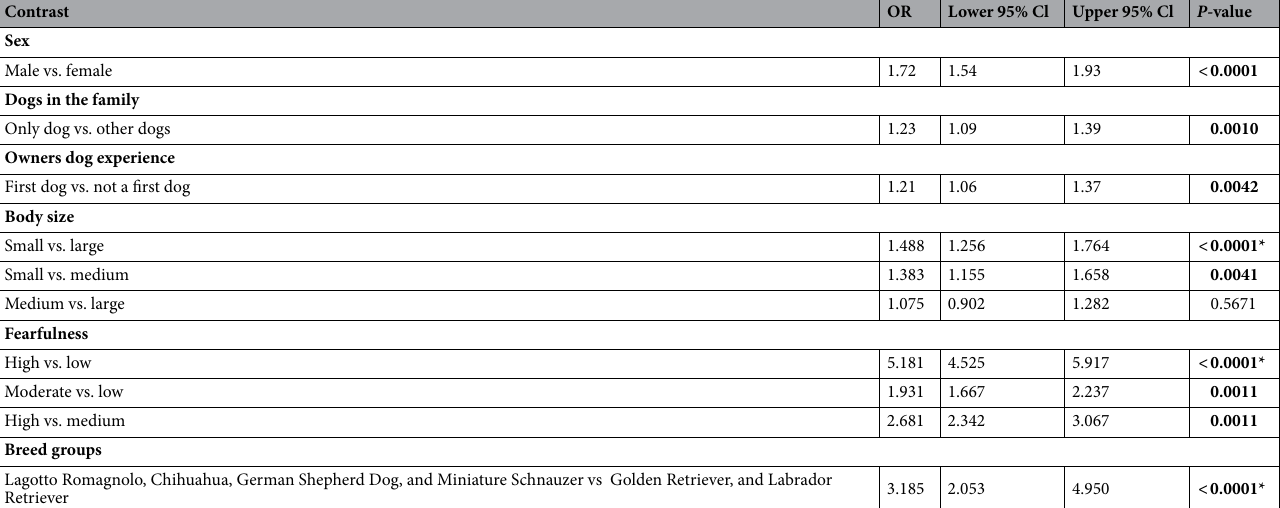
Table 2. Contrasts between different groups of categorical and ordinal variables in the logistic regression analysis. P -values are controlled for false discovery rate except for a priori contrasts, which were formed after the data collection, but before the analysis. A priori contrasts are marked with *. Significant P -values are bolded ( P -value < 0.05) OR odds ratio, Cl confidence limit, N = 9270.